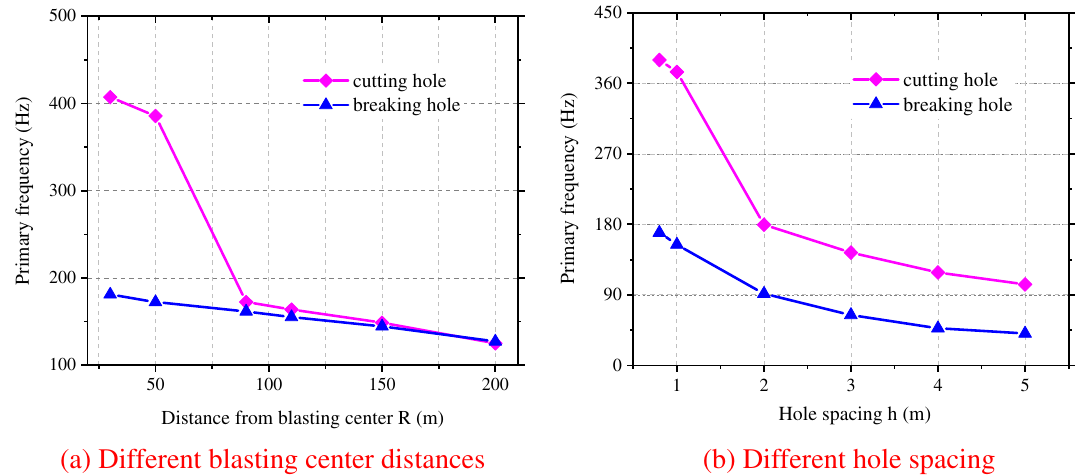
Figure 3. Primary frequency attenuation curve of group hole blasting